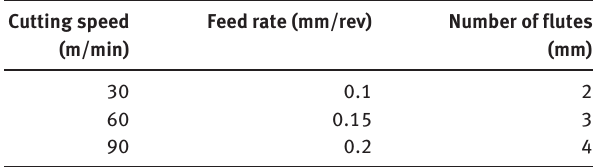
Table 1 Cutting parameters and